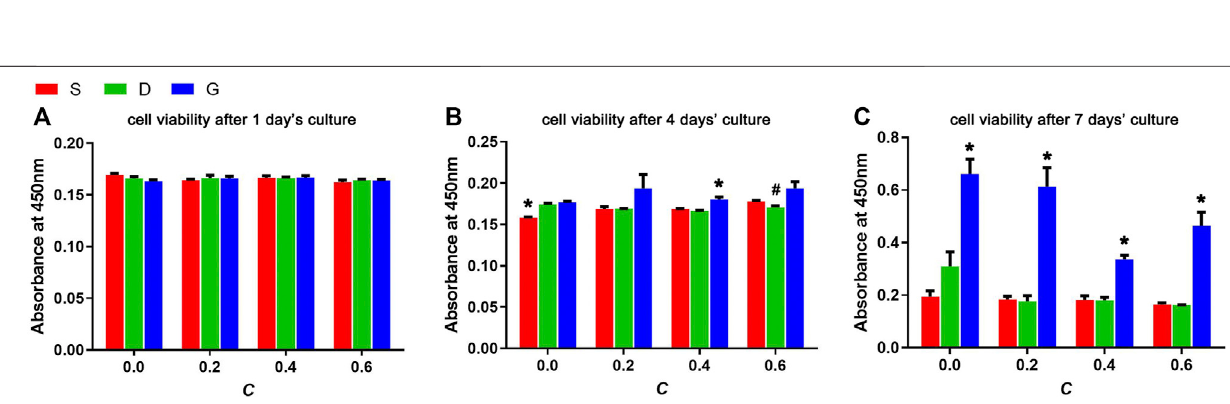
FIGURE 8 | Mechanical stress – strain curves of the manufactured specimens. The peak stress at the end of initial elastic loading stage in curve is generally considered to be the bearable maximum stress of the porous scaffold before structure yielding. Three repeats were performed for each group.